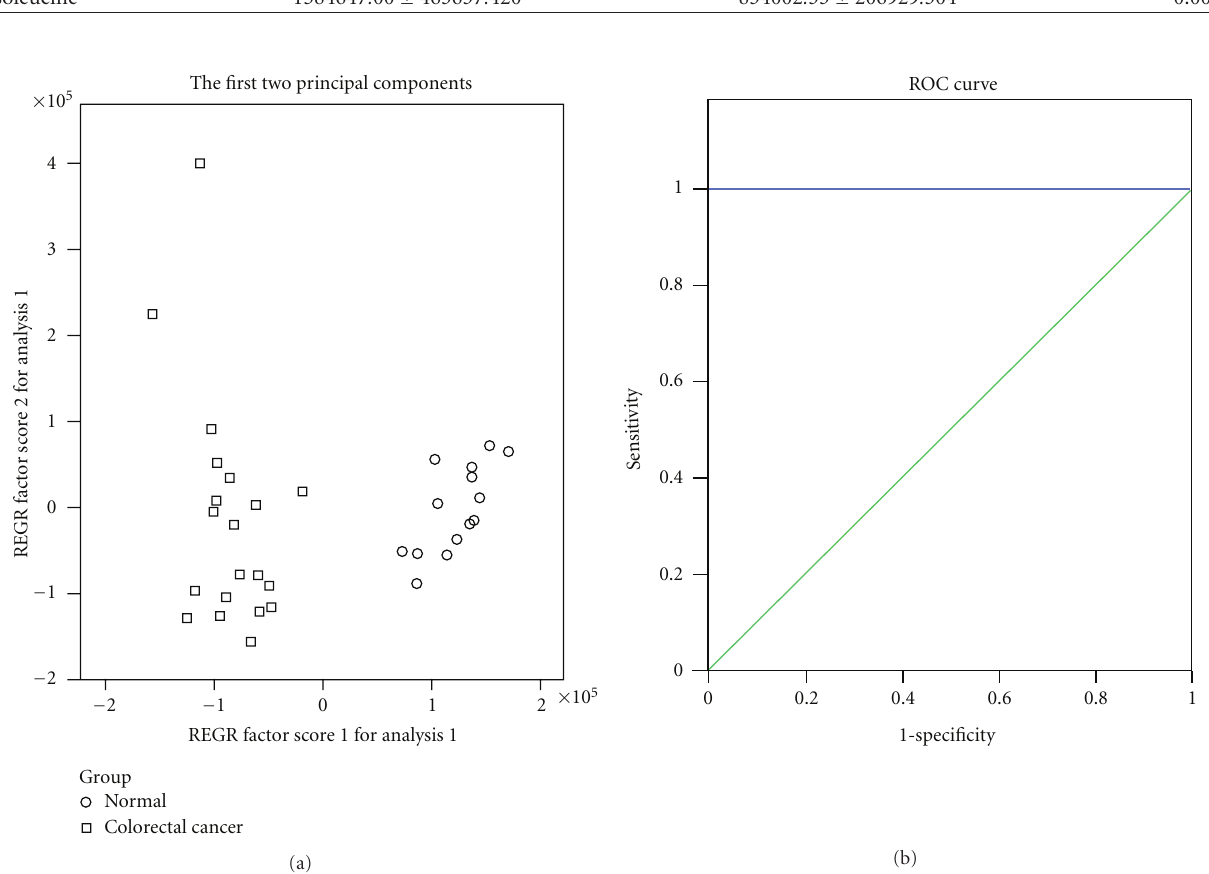
Figure 3: Principal component analysis model and receiver operating characteristic curve for colorectal cancer. (a) Principal component analysis (PCA) scores plot of colorectal cancer urine specimens from control specimens based on 12 marker metabolites. The PCA scores plot showed that di ff erent samples (normal group, colorectal cancer group including early stage group and advanced group) were scattered into di ff erent regions; (b) receiver operating characteristic (ROC) analysis was performed using the values determined by the first two principal components. Area under the curve (AUC) =